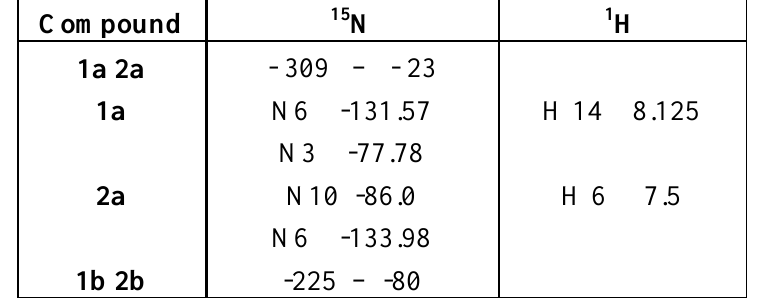
Table 1 . Calculated 15 N- and 1 H-NMR chemical shifts δ [ppm] of type a and b